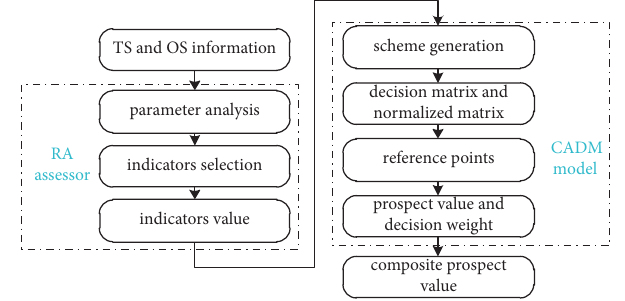
Figure 1: The framework for